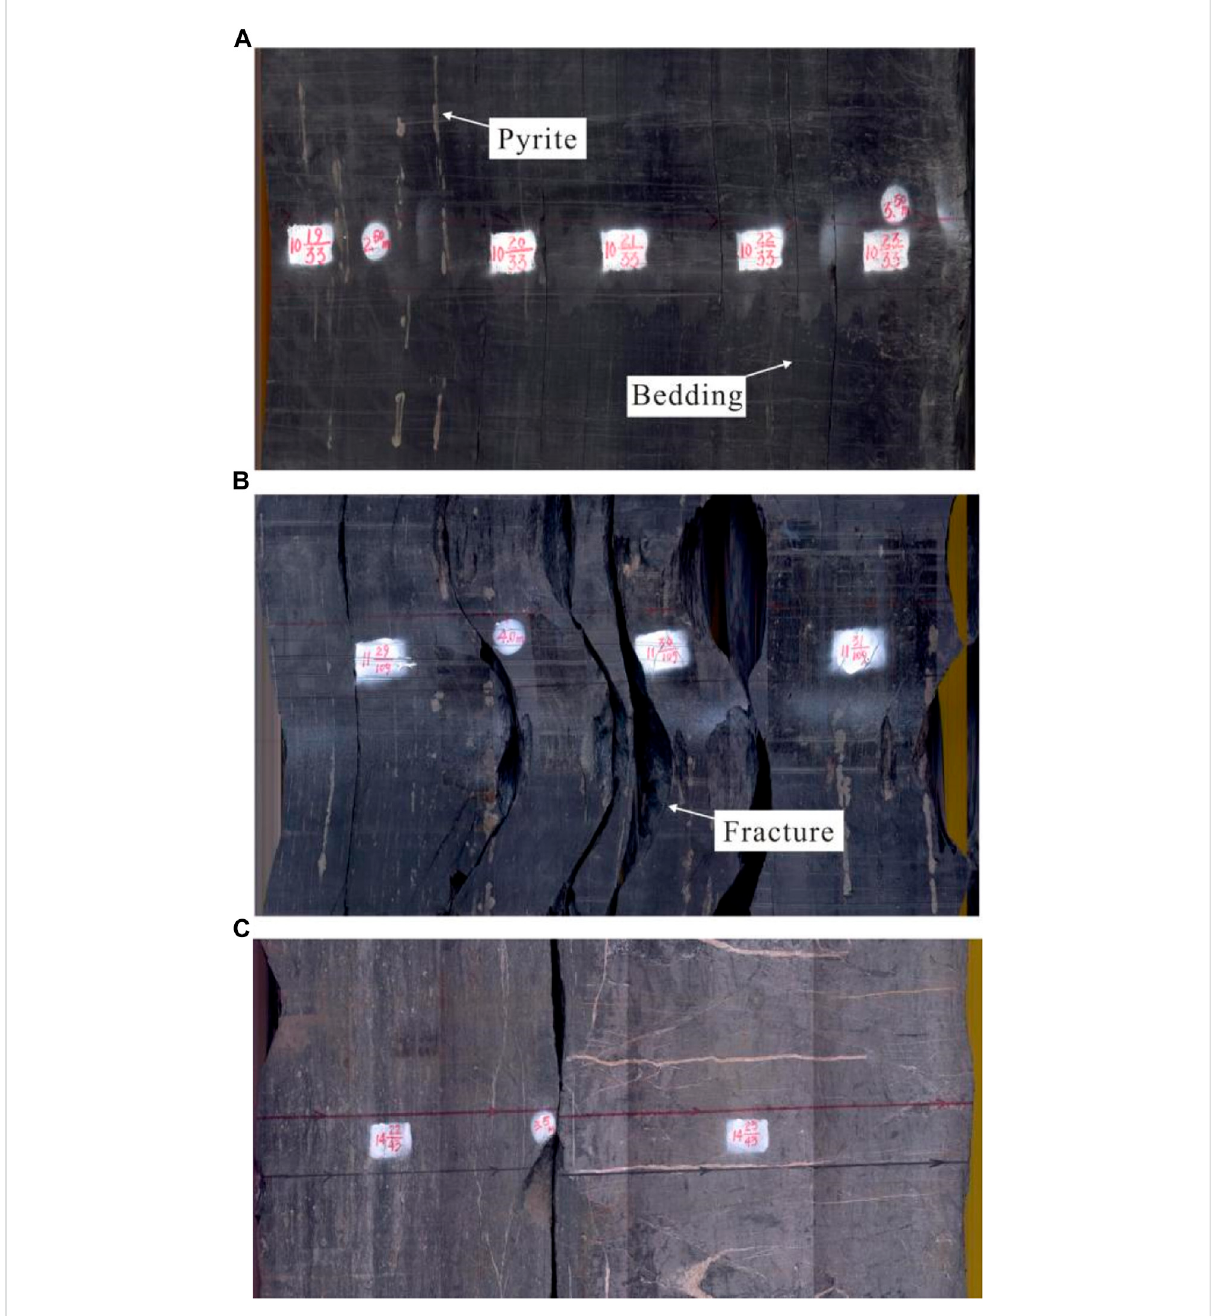
FIGURE 3 Developmentcharacteristics ofdifferenttypesofshaleinWell MY1. (A) 2,895.25 – 2,895.91 m; (B) 2,916.6 – 2,917.4 m; (C) 2,959.24 – 2,969.13